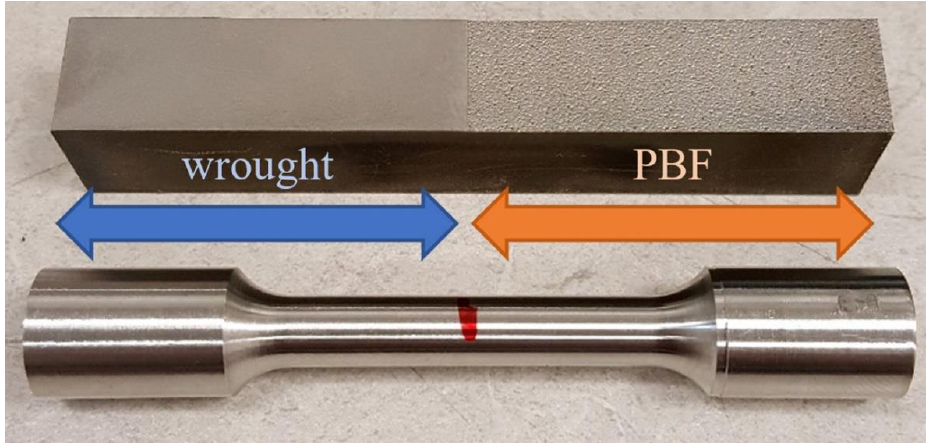
Figure 2. A 3-inch torsion specimen design (ASTM E8).